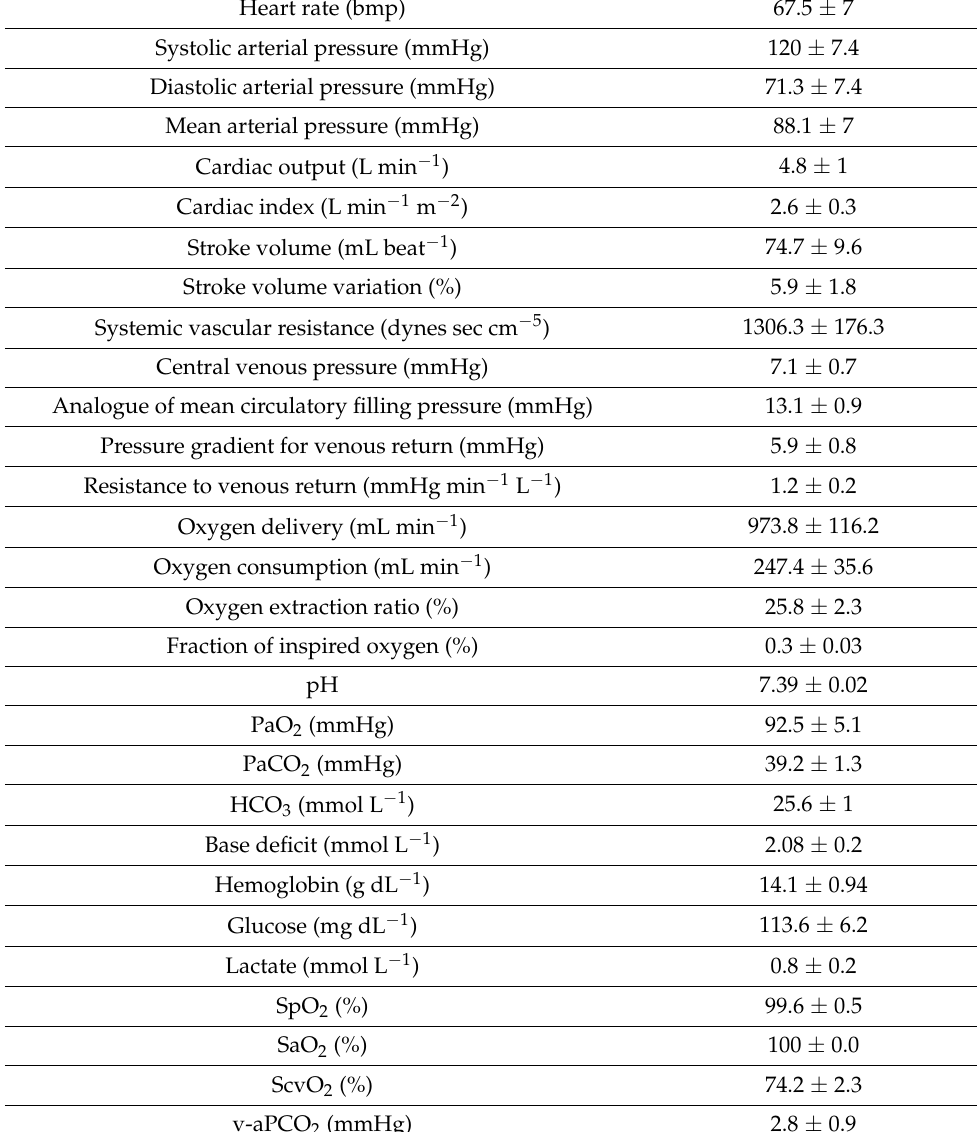
Table 1. Baseline systemic hemodynamic and metabolic